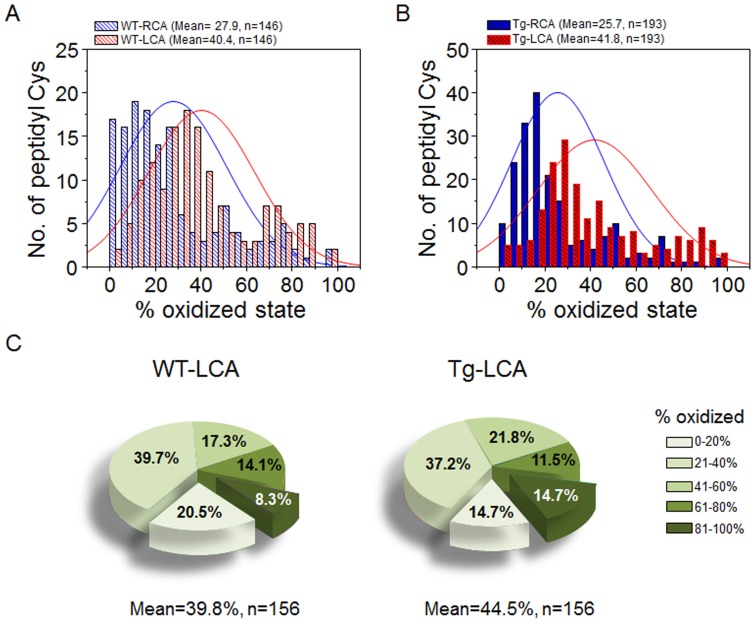
Distribution of oxidized state of peptidyl Cys in RCA and LCA of WT and NLS-Trx1 Tg mice.Histograms (A, B) show numbers of peptidyl Cys identified by redox ICAT/MS according to % oxidation measured in RCA and LCA of each WT (A) and NLS-Trx1 Tg (B) mice. C, Pie charts show the distribution of oxidized peptidyl Cys of WT-LCA and Tg-LCA. P-values analyzed by Chi-square test comparing RCA and LCA from WT (A), RCA and LCA from Tg (B), and subset of peptides (C) from LCA of WT and Tg are as follows: RCA (WT) vs. LCA (WT), p = 9.53×10−31; RCA (Tg) vs. LCA (Tg), p = 1.37×10−55, LCA (WT) vs. LCA (Tg), p = 0.0225.